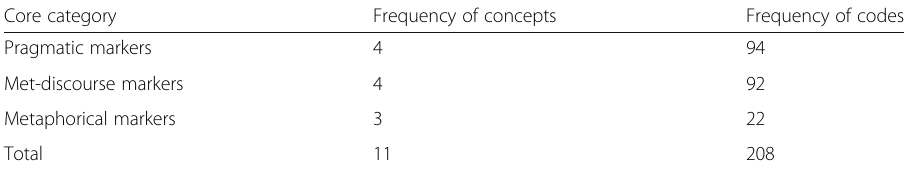
Table 3 Frequency of Obtained Codes and